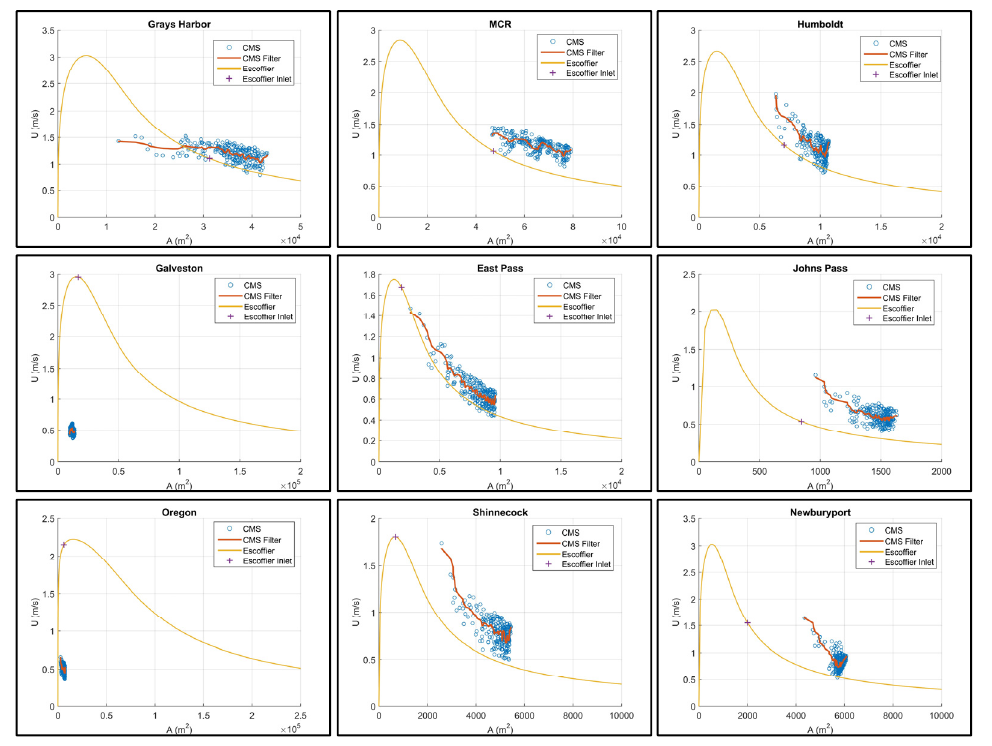
Figure 13. Escoffier curve for the idealized inlets. CMS denotes model estimates and plus symbols denote the cross ‐ sectional area of the real inlets. Open circles are the model predicted maximum flow versus inlet cross ‐ sectional area.